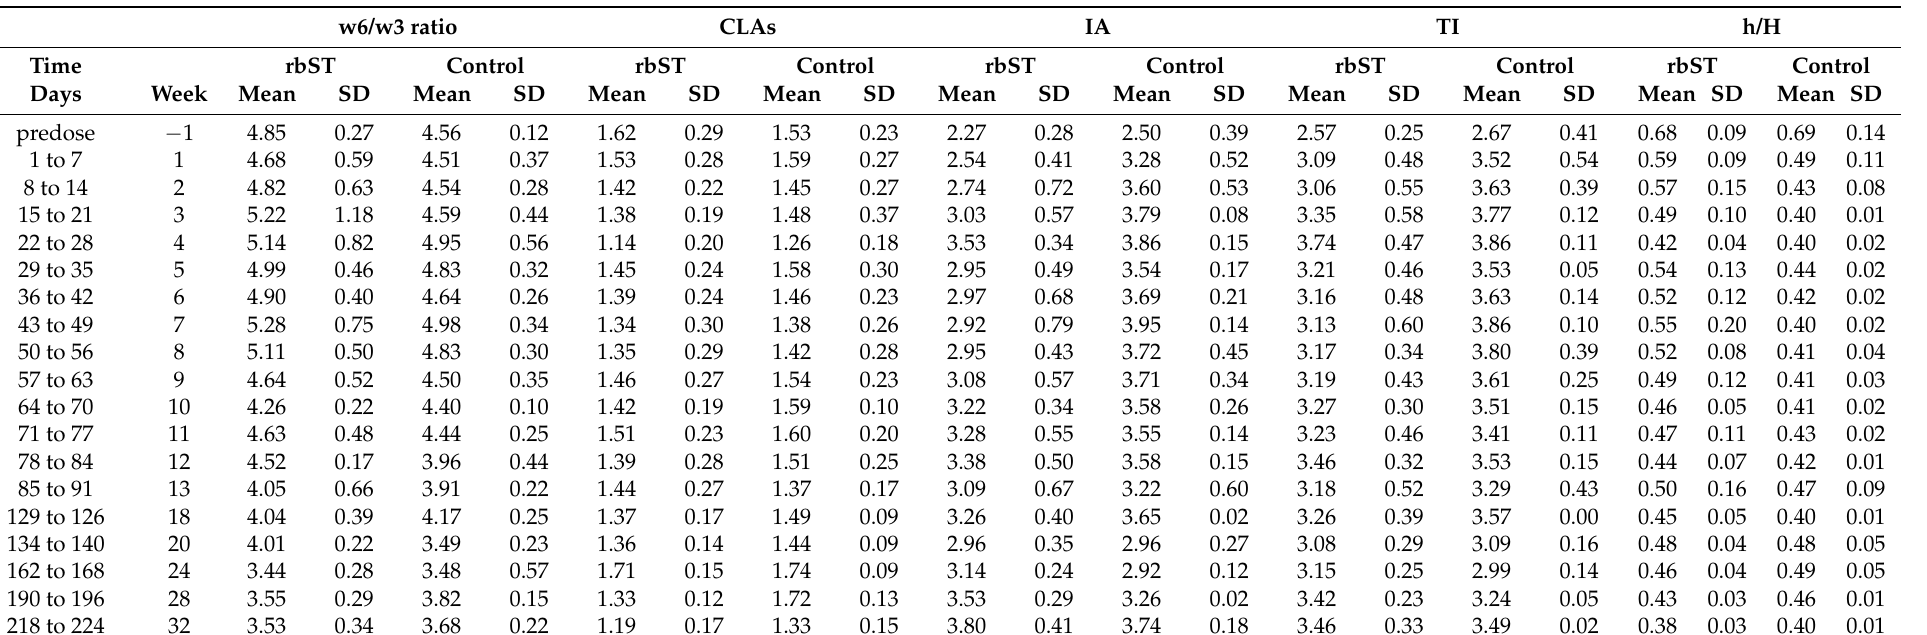
Table 9. Quality indexes of fat of milk obtained from cows treated with recombinant bovine somatotropin (rbST) ( n = 6) and from control animals ( n = 3) at different time points selected over the course of 37 weeks (8 injections of Lactotropina manufactured by Elanco, Eli Lilly, Mexico). w6/w3 ratio CLAs IA